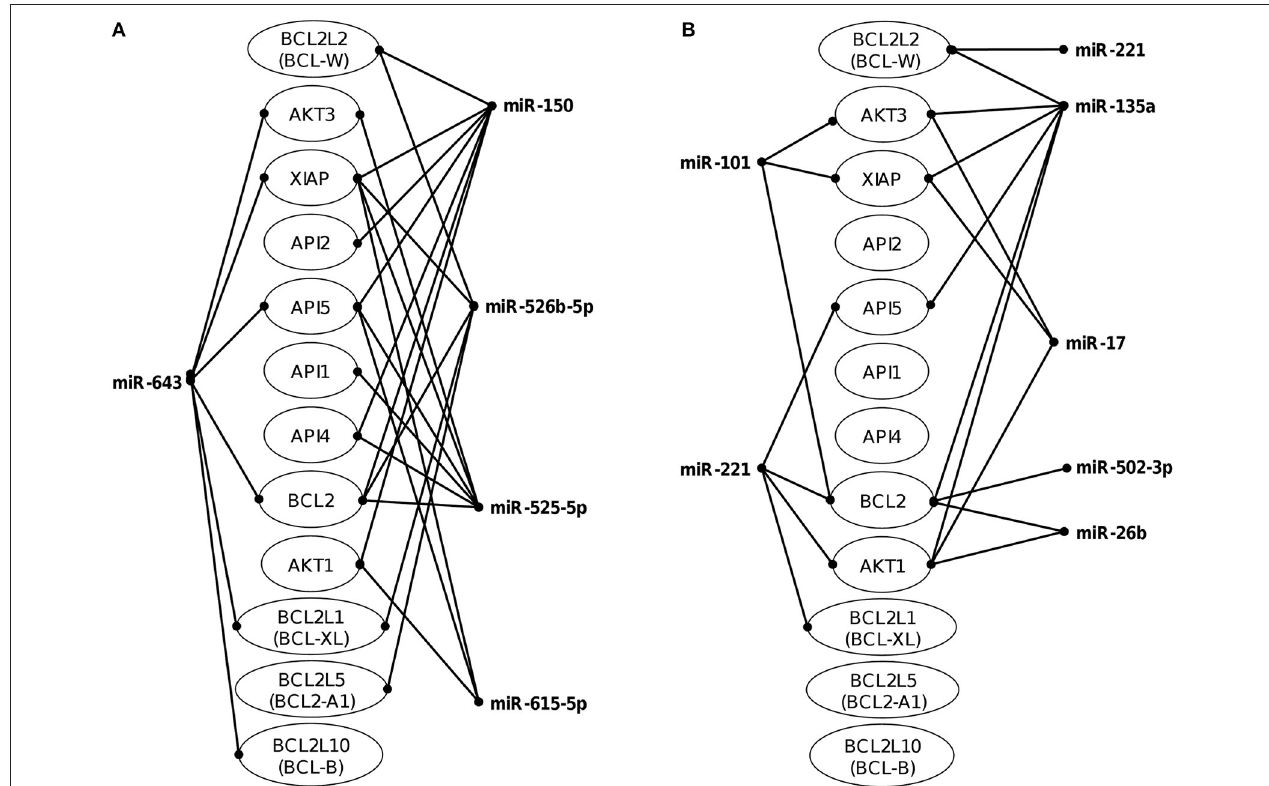
FIGURE 3 | Co-regulation networks of modulated miRNAs and predicted target mRNAs. Image depicts the interaction networks of miRNAs modulated at (A) 45min and (B) 75min after interaction of SW-480 cells with E. histolytica . Target mRNAs were predicted by at least two of the three programs used (DIANA-microT, TargetScan, and miRanda). Genes related to apoptosis were also included even if they were targeted by only one